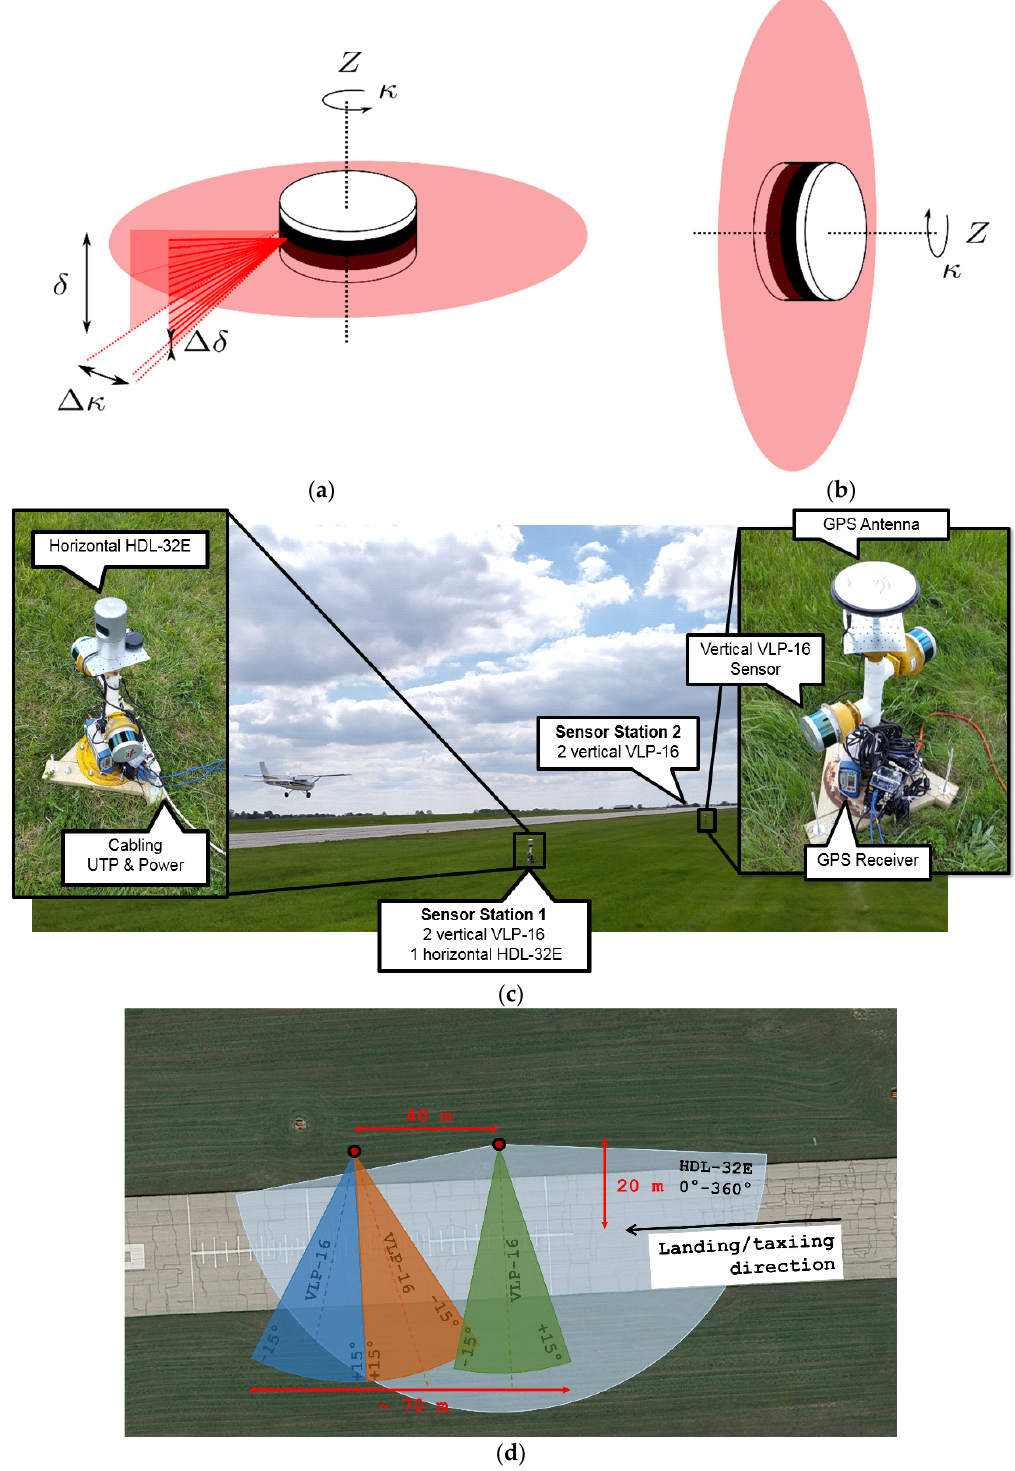
Figure 1. Sensor system overview: ( a ) horizontally and ( b ) vertically aligned VLP-16 sensor, ( c ) components of the demonstration sensor network, and ( d ) sensor